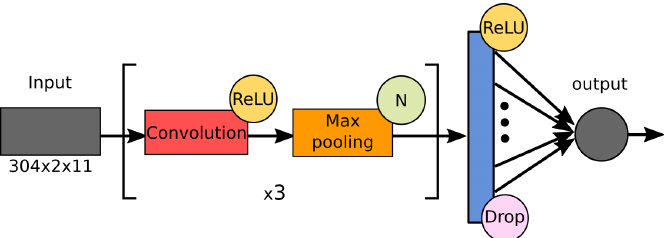
Figure 7. Common architecture of the tested networks, M1-M32.